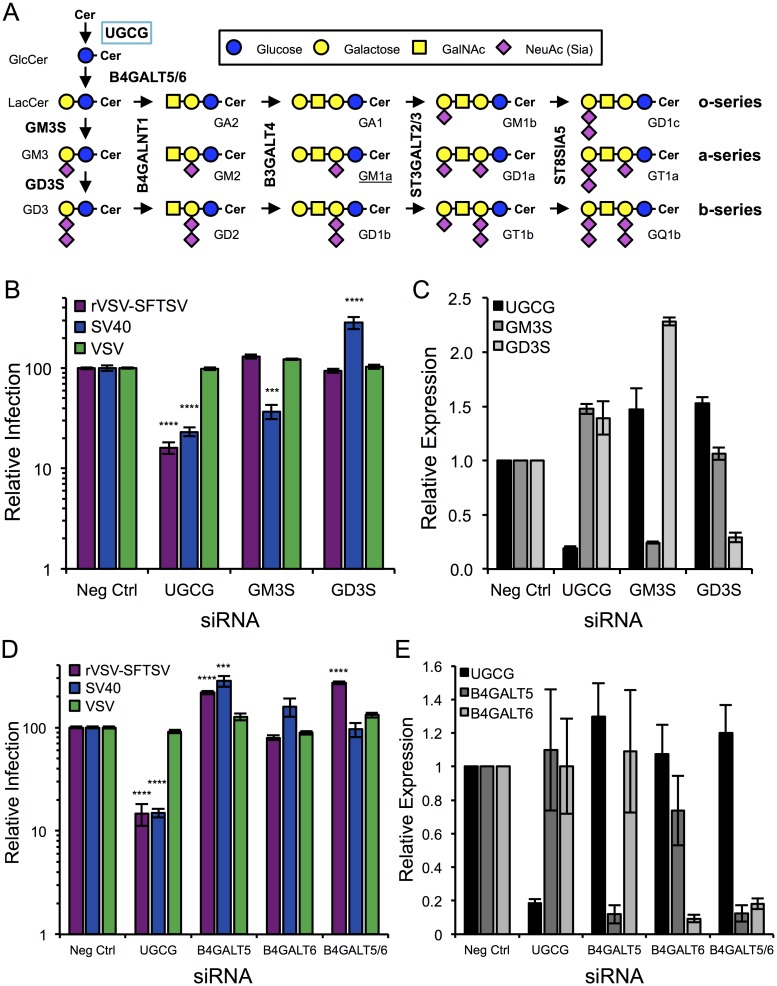
Analysis of downstream glycosphingolipid biosynthesis.(A) Diagram of Ganglioside Biosynthesis. Unique enzymes are responsible for the formation of GlcCer, LacCer, GM3 and GD3 (left hand side). These substrates are then modified by common enzymes in a step-wise manner to attach additional sugar moieties. Each of the o-, a-, and b-series branches are a committed pathway, since sialyltransferases cannot convert an a-series ganglioside to a b-series (excluding the conversion of GM3 to GD3). (B) U-2 OS cells were transfected with siRNAs targeting UGCG, GM3 Synthase (GM3S), GD3 Synthase (GD3S), or a non-targeting control (Neg Ctrl) and 72 hours later were infected with rVSV-SFTSV, VSV, or SV40. Ten hours (rVSV-SFTSV, VSV) or 24 hours (SV40) post-infection cells were harvested, immunostained for viral antigen, and analyzed by flow cytometry. Mean ± S.E.M. for 3 independent experiments. (C) mRNA levels for UGCG, GM3S, and GD3S were determined for (B) using RT-qPCR, normalized to GAPDH mRNA levels, and expressed relative to the negative control siRNA. (D) U-2 OS cells were transfected with siRNAs targeting UGCG, B4GALT5, B4GALT6, both B4GALT5 and B4GALT6 (B4GALT5/6), or a non-targeting control (Neg Ctrl). 72 hours post-transfection cells were infected with rVSV-SFTSV, VSV, or SV40. Ten hours (rVSV-SFTSV, VSV) or 24 hours (SV40) post-infection cells were harvested, immunostained for viral antigen, and analyzed by flow cytometry. Mean ± S.E.M. for 3 independent experiments. (E) mRNA levels for UGCG, B4GALT5, and B4GALT6 from siRNA-transfected cells were determined by RT-qPCR, normalized to GAPDH mRNA levels, and expressed relative to the negative control siRNA. *** p<0.001, **** p<0.0001 using Student’s t-test with Bonferroni correction.